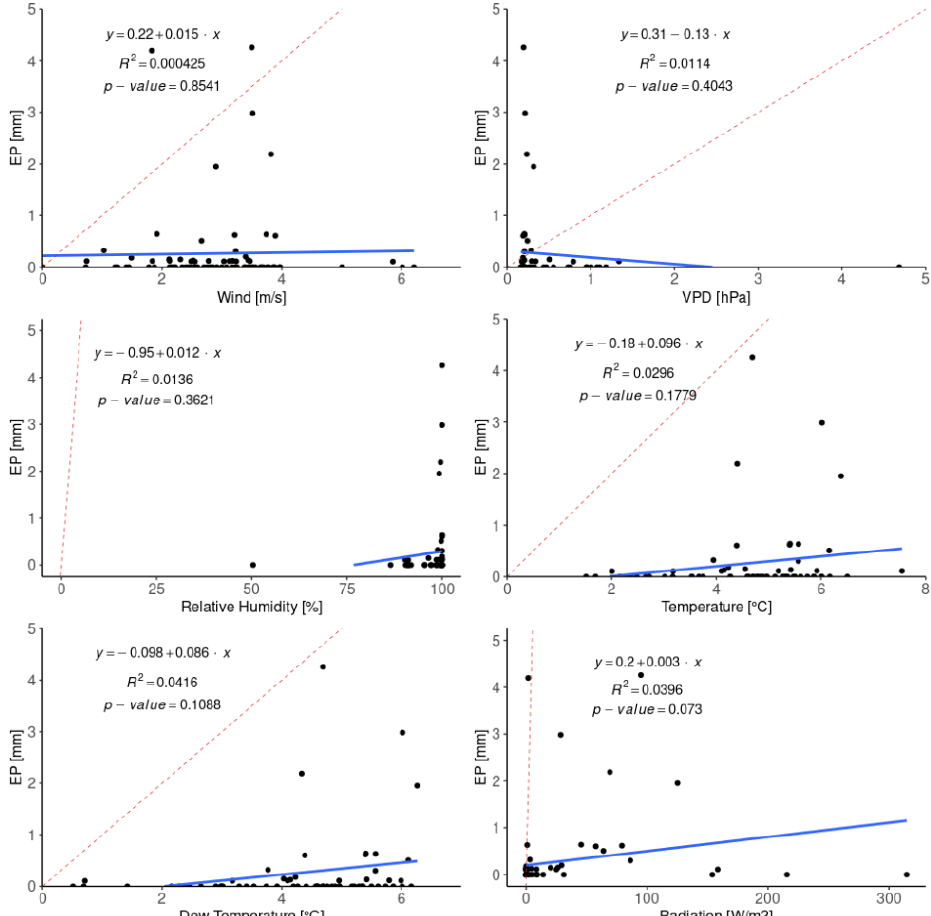
Figure 6. Effective precipitation (EP) versus meteorological variables for the two types of events fog-only and cloud-water (black dots), with the corresponding coefficient of determination, where the blue line represents the linear regression model and the red line is the identity line (slope = 1).